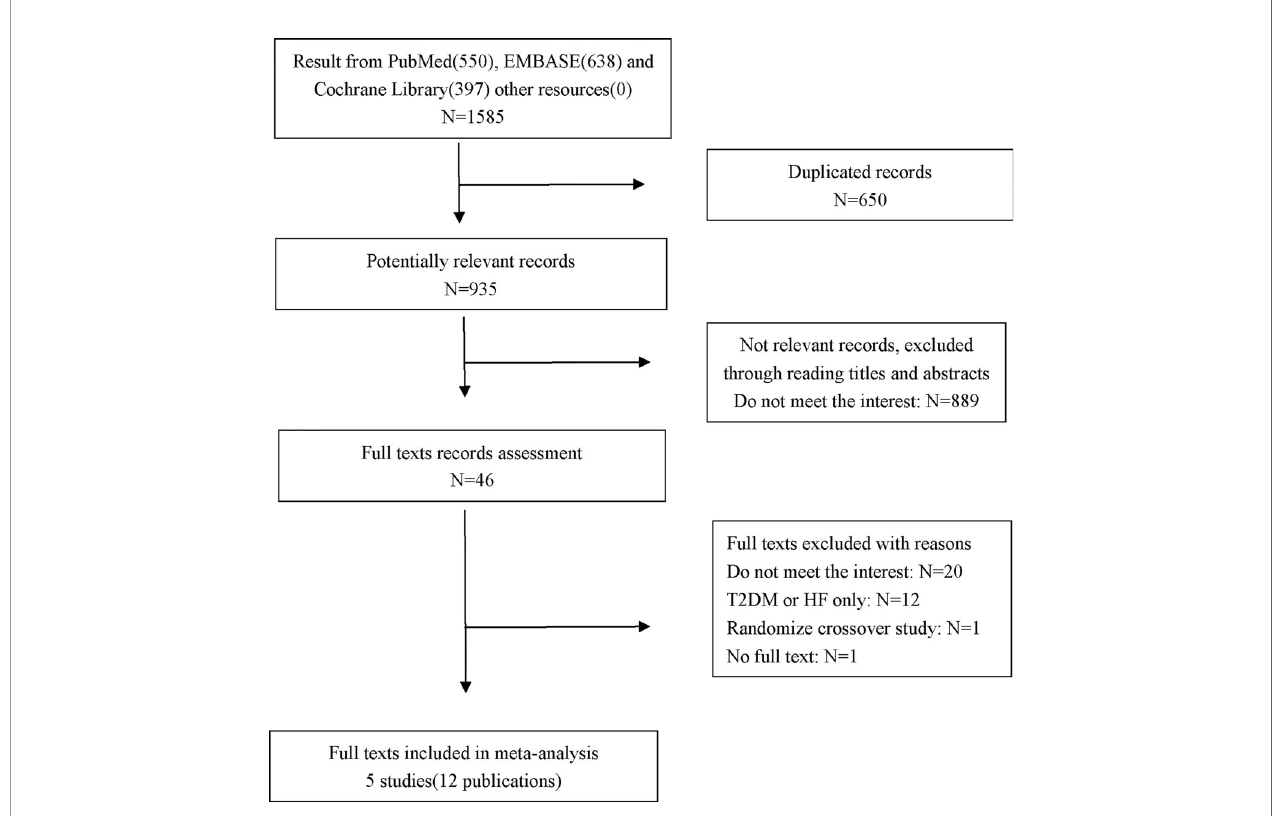
FIGURE 1 | Process of study